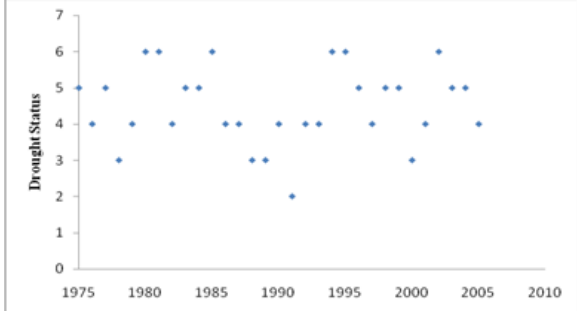
Figure 7. Region drought status based on SPI.